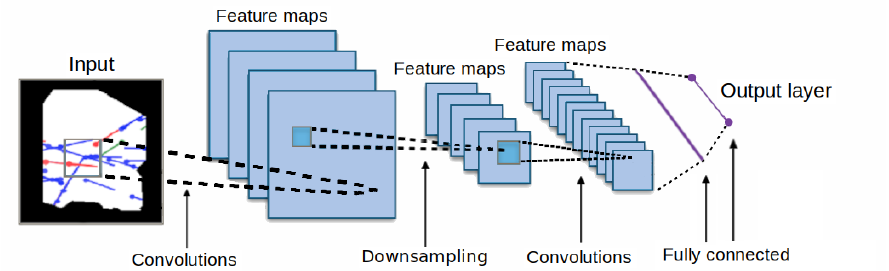
Figure 5. Conventional CNN architecture with two convolutional and pooling (down-sampling) layers.